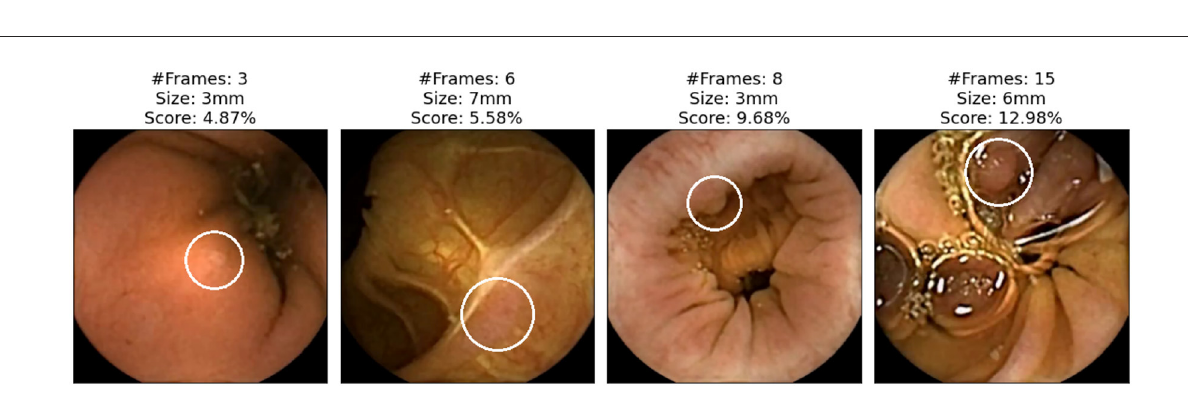
FIGURE5 Polyp frames to which the app has attributed a small score and, therefore, none of the experts have been able to review in the first 30 min. Polyps are circled in white.